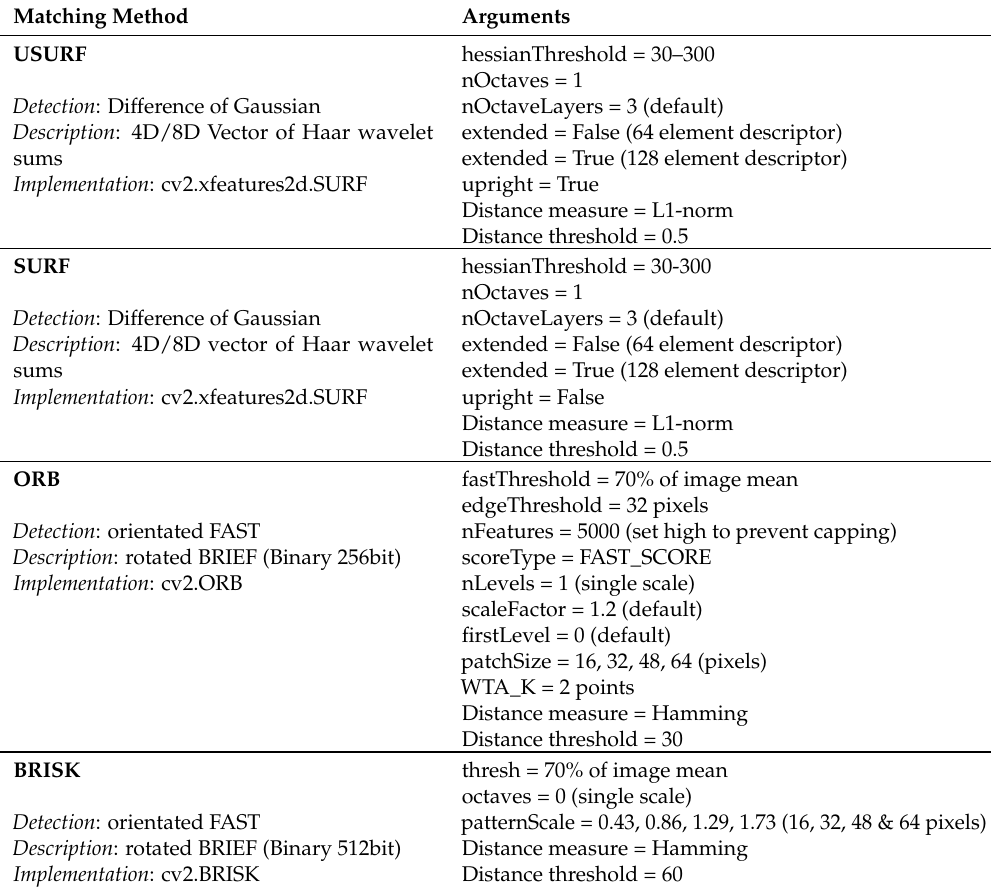
Table 2. Summary of feature description methods, OpenCV python implementation, and parameters